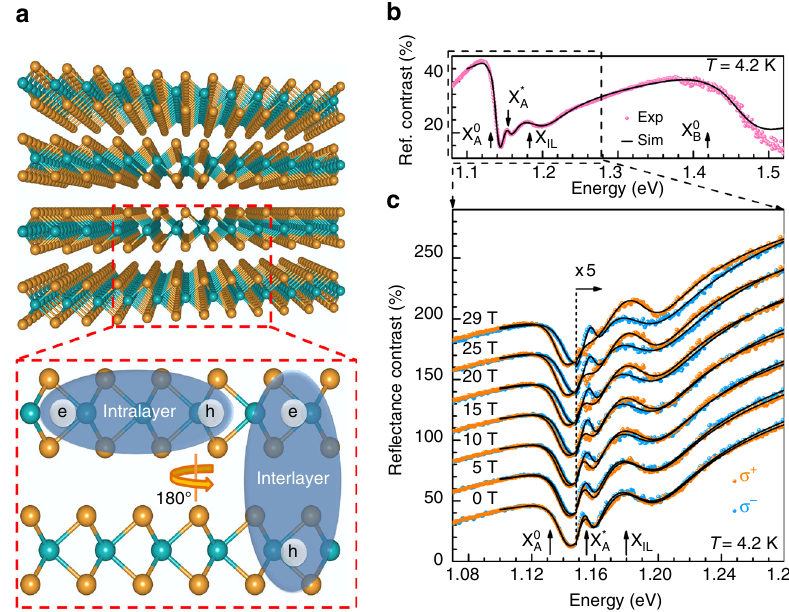
Fig. 1 Crystal structure and magneto-re fl ectance spectra of bulk MoTe 2 . a Schematic drawing of the layer con fi guration in bulk 2H-MoTe 2 , highlighting intralayer and interlayer excitons. b Microre fl ectance contrast ( μ RC) spectrum of a 40 nm-thick 2H-MoTe 2 crystal on SiO 2 (80 nm)/Si substrate in the absence of a magnetic fi eld ( B = 0) ( spheres ) together with the modeled spectrum ( solid line ). c Helicity-resolved μ RC spectra at different magnetic fi elds B = 0 – 29 T ( spheres ) with the modeled spectra ( solid curves ). The spectra are vertically shifted with respect to 0 T spectrum for